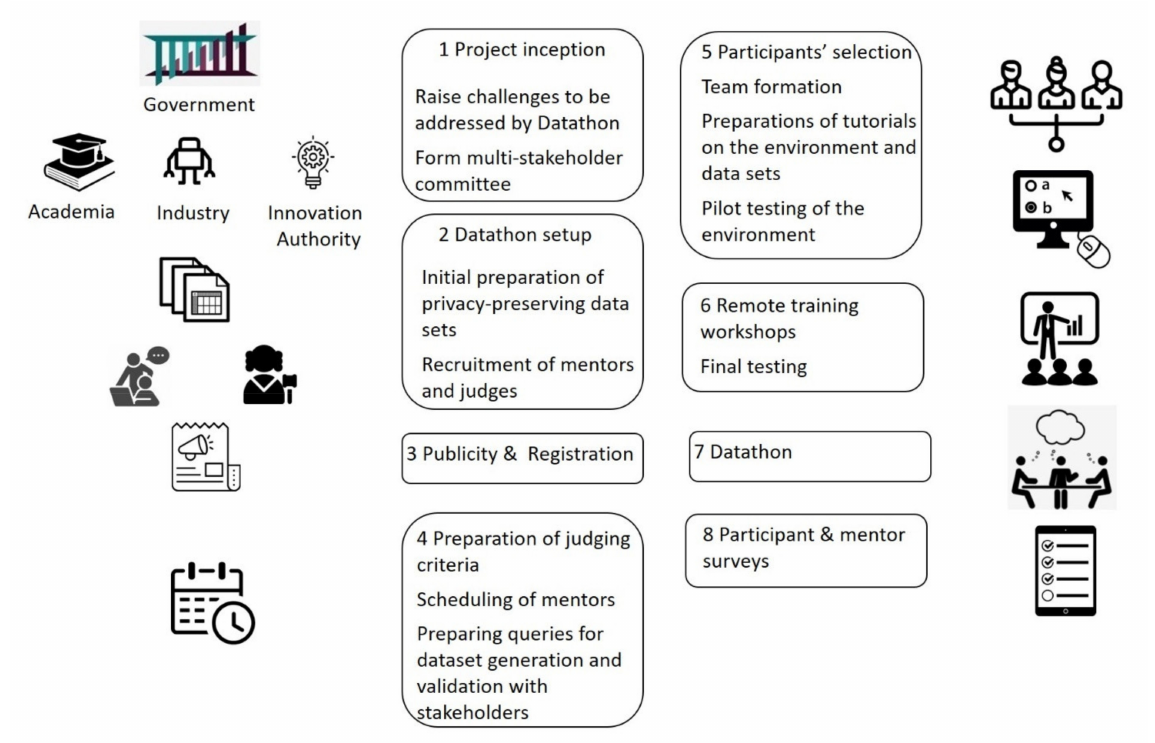
Figure 1. Process of Datathon